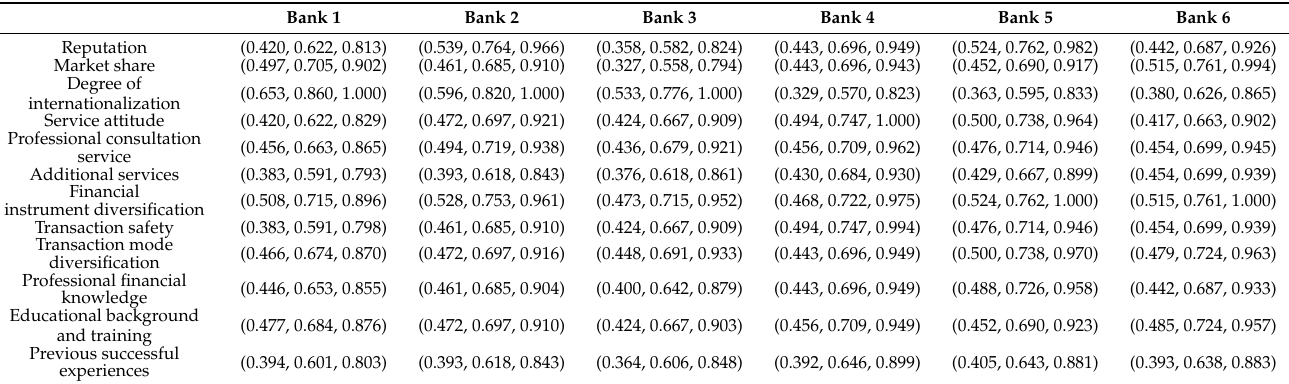
Stage 3: Calculate the normalized matrix. We can adopt Equation 2 to calculate the normalizing matrix (Table 5). Table 5. Normalized fuzzy decision-making matrix.